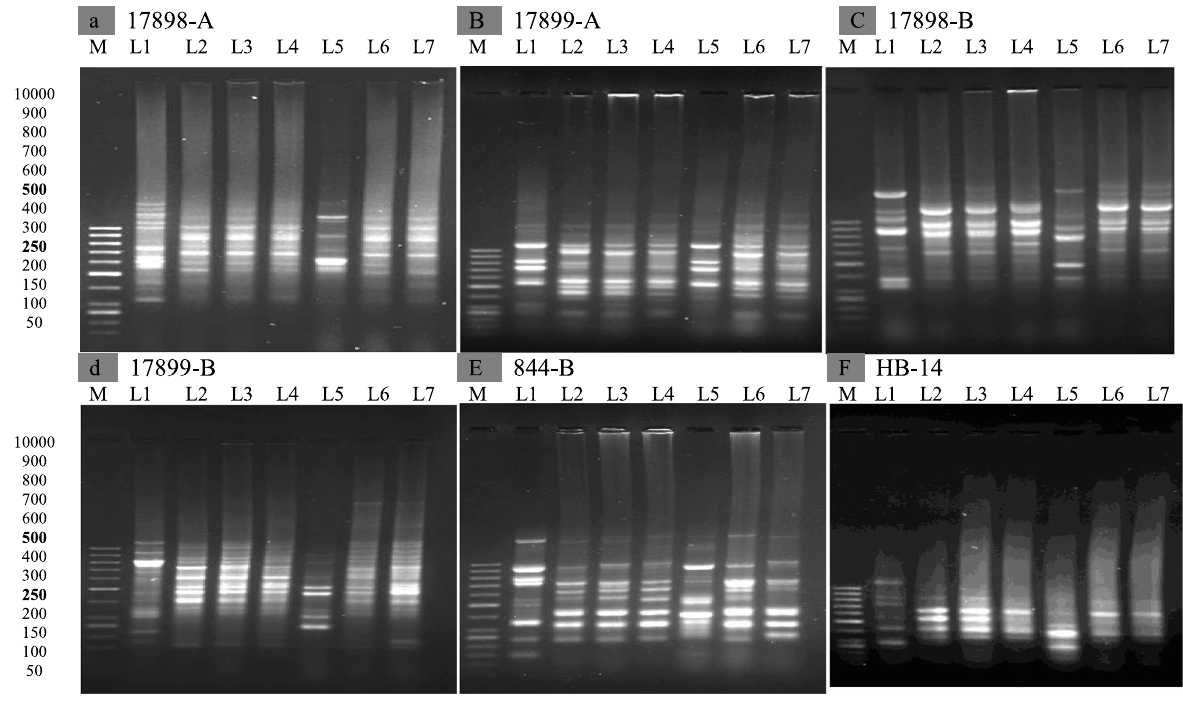
Fig. 1 The inter-simple sequence repeats (ISSR) amplification pattern obtained for seven wheat lines a primer 17898-A, b primer 17899-A,